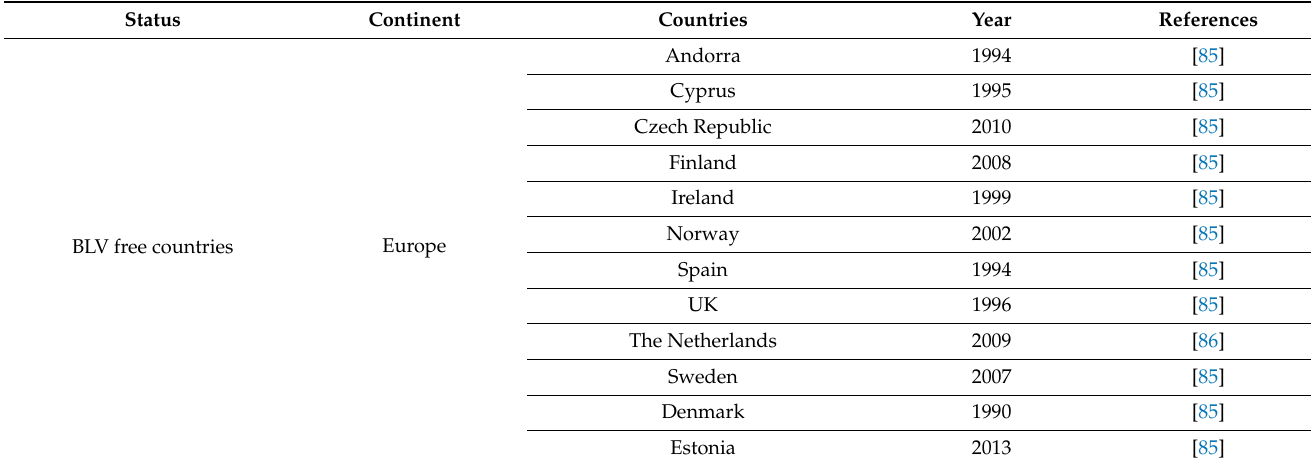
Table 2. Prevalence of the bovine leucosis disease worldwide, adopted from